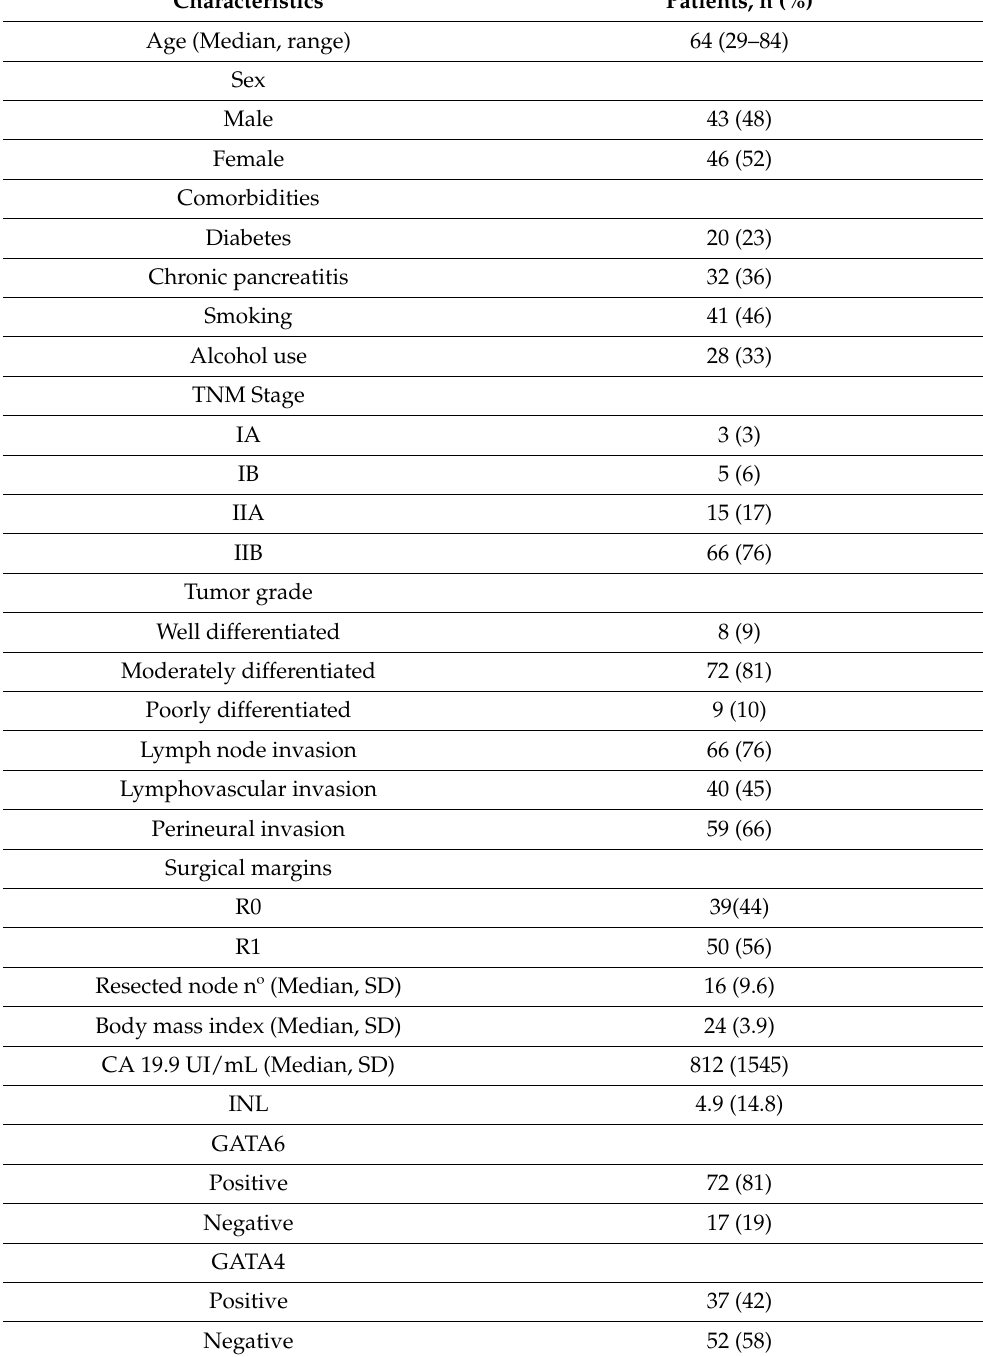
Table 1. Baseline patients’ characteristics ( n =